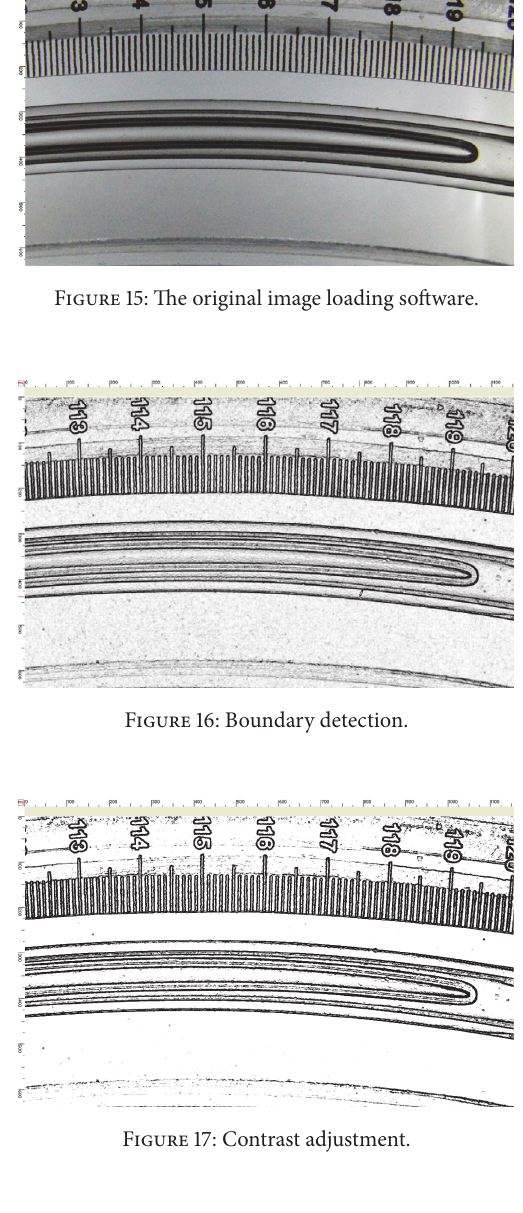
Table 3: The multiples of the diameter from the tip width of the long bubbles approached to a constant value.